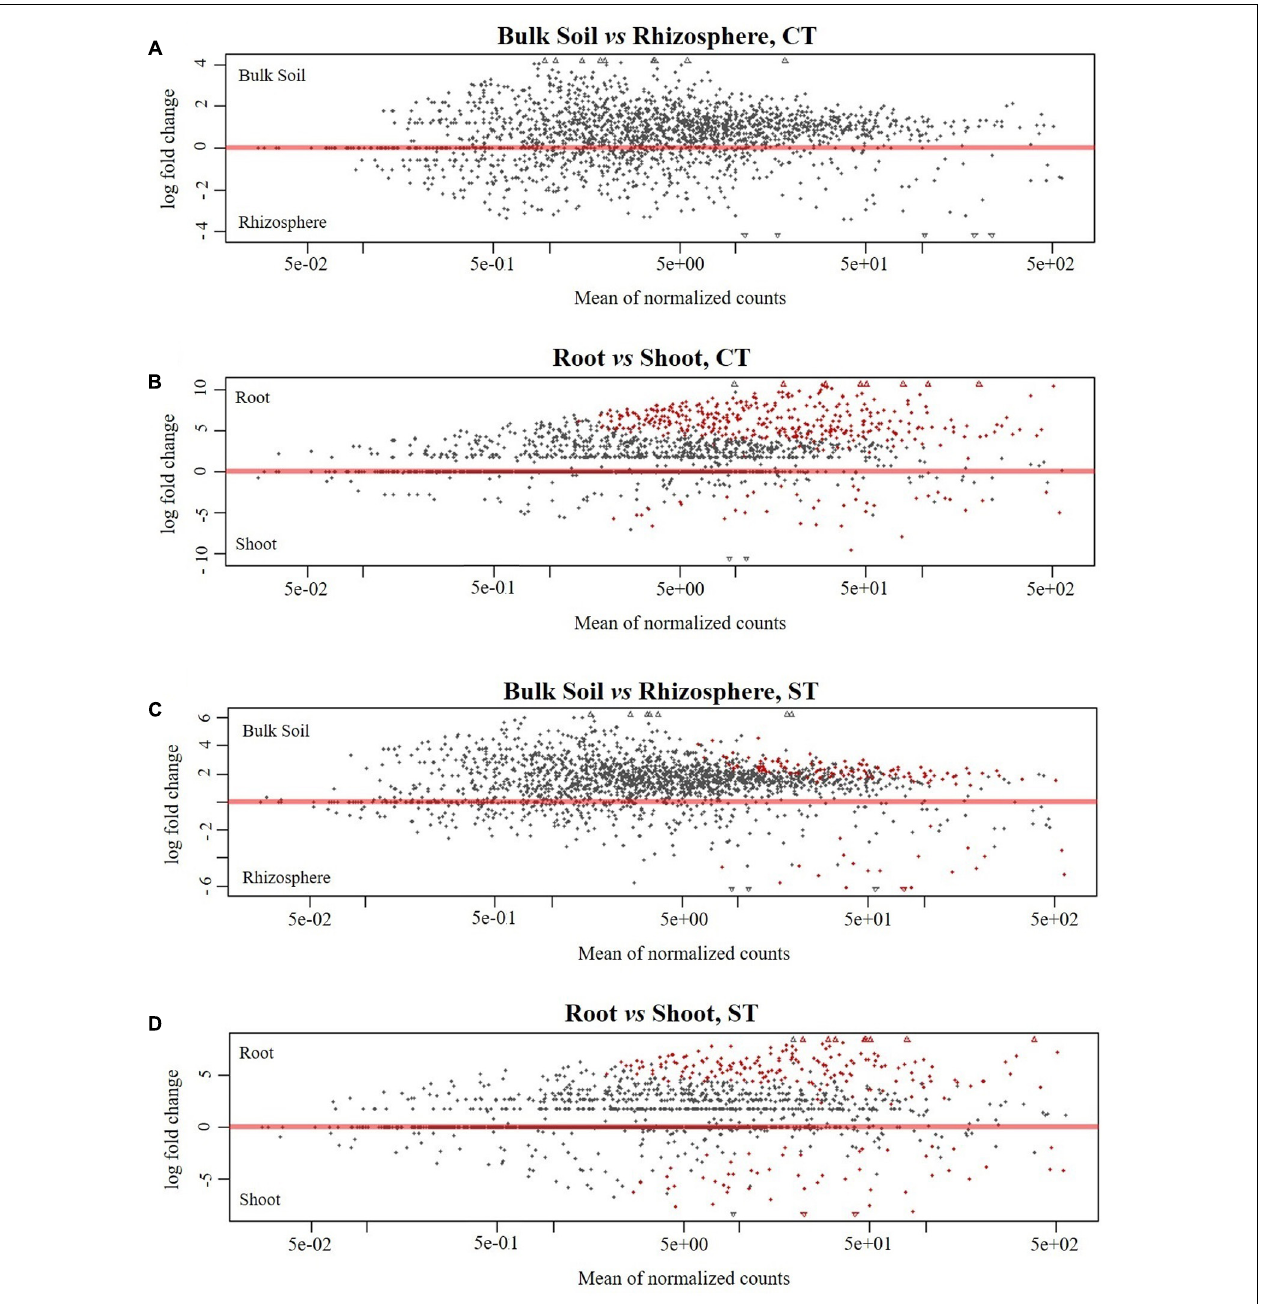
FIGURE 4 | Pair-wise comparisons of the compartments under tillage regimes for enriched OTUs. Comparison of bulk soil and rhizosphere under (A) CT (C) ST. Comparison of root and shoot under (B) CT (D) ST. In each plot, the shapes depict individual OTUs whose position on the x -axis reflect their abundance (normalized counts) and the position on the y -axis the fold change in the indicated comparison. The red color depicts OTUs whose abundance is significantly different in the indicated comparisons (Wald test, P < 0.05, FDR corrected). Taxonomy information of significantly enriched OTUs in each compartment under both tillage are displayed in Supplementary Excel File